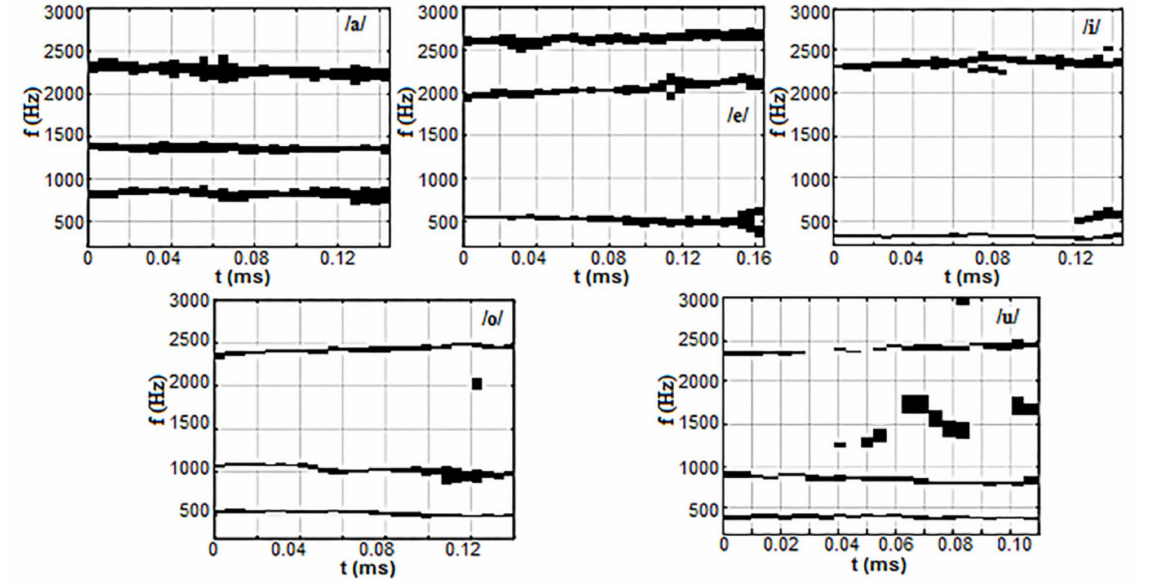
Figure 3. Lateral inhibition process result.